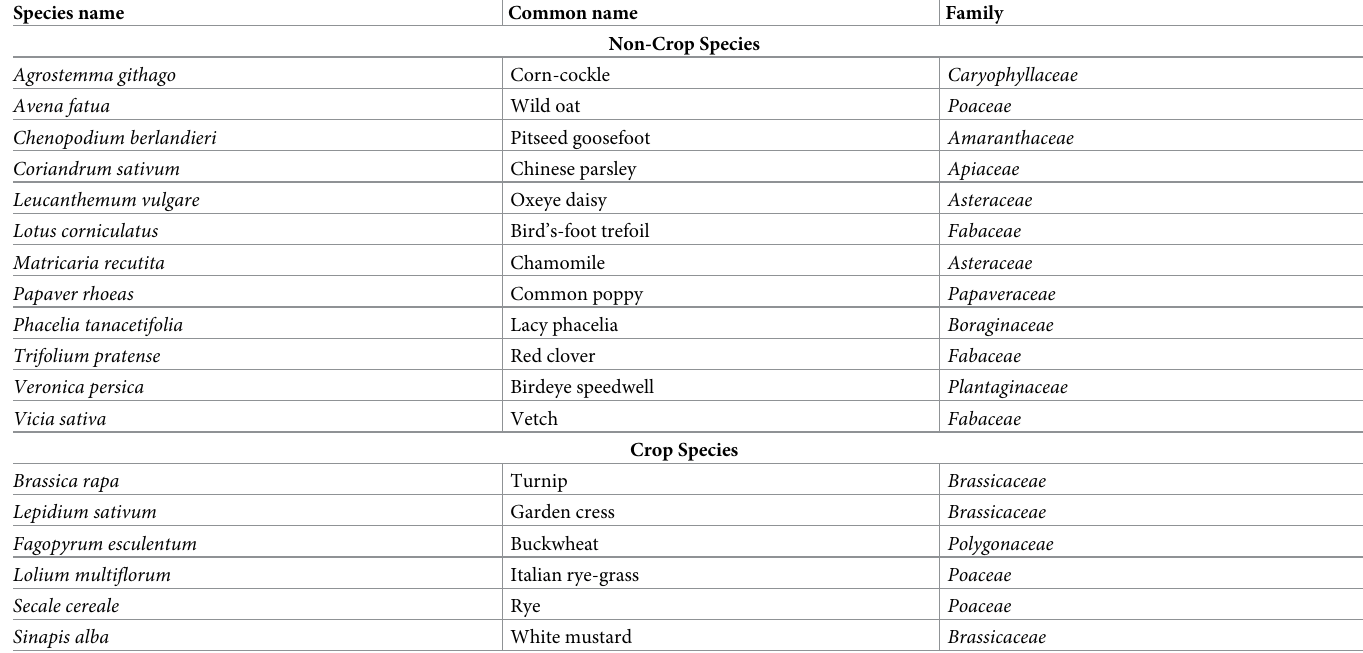
Table 1. Crop and non-crop plant species selected for the conduct of the